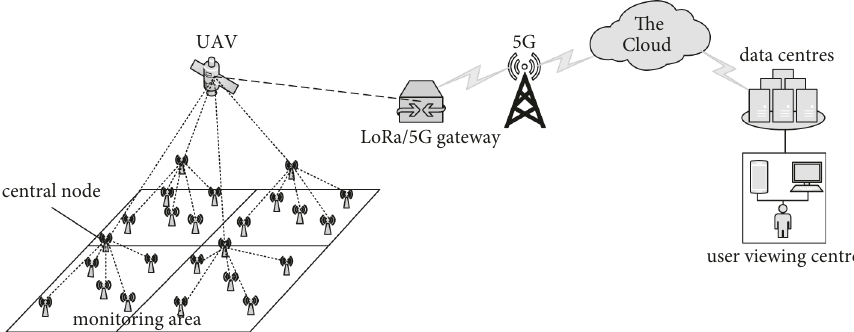
Figure 1: UAV-SREMS system structure.